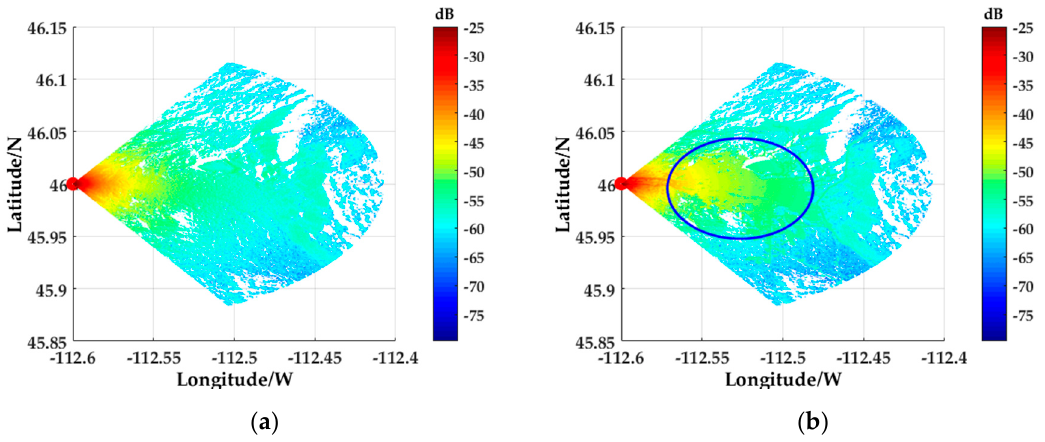
Figure 11. Comparison of clutter power spectrum: ( a ) The clutter power spectrum obtained by using only DEM data proposed in [13]; ( b ) The clutter power spectrum obtained by the method proposed in this paper.